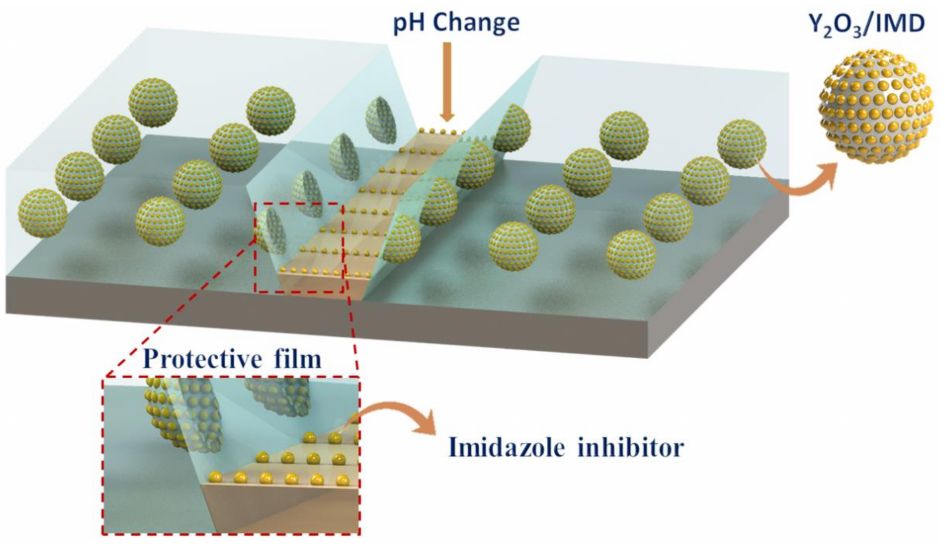
Figure 11. The schematic diagram explaining inhibition